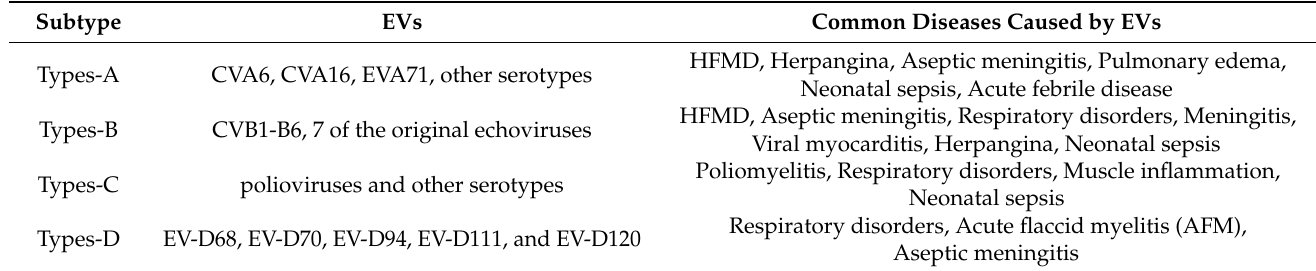
Table 1. Classification of enteroviruses (EVs) and their corresponding